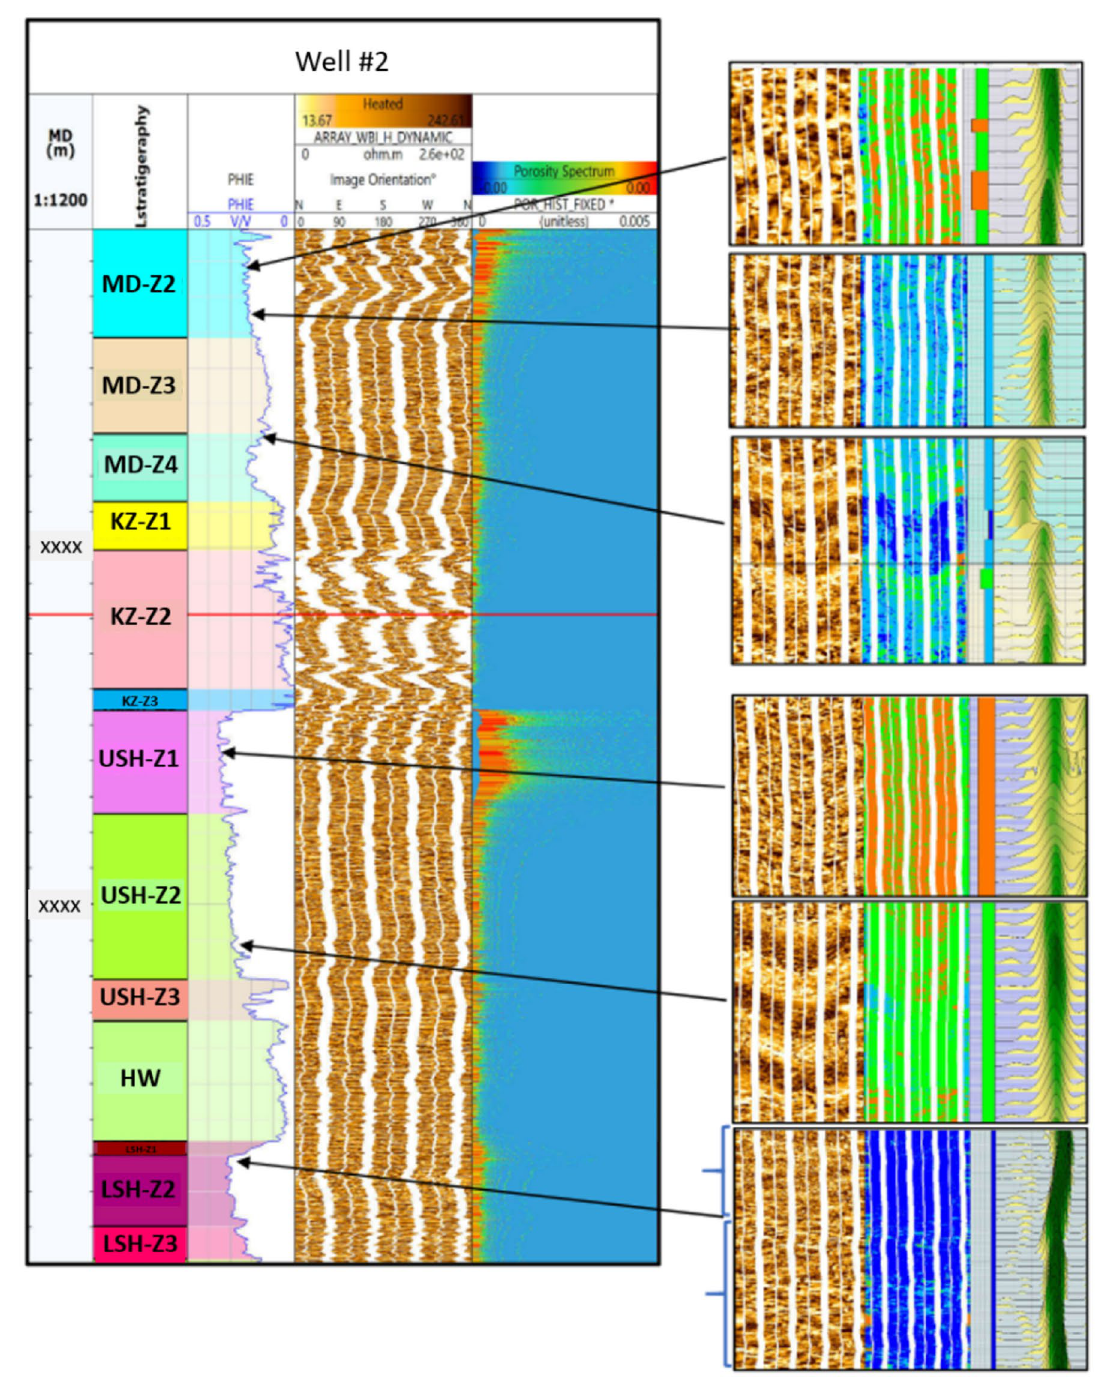
Fig. 10 Porosity distribution vertically from Mauddud to L. Shuaiba Formation in well